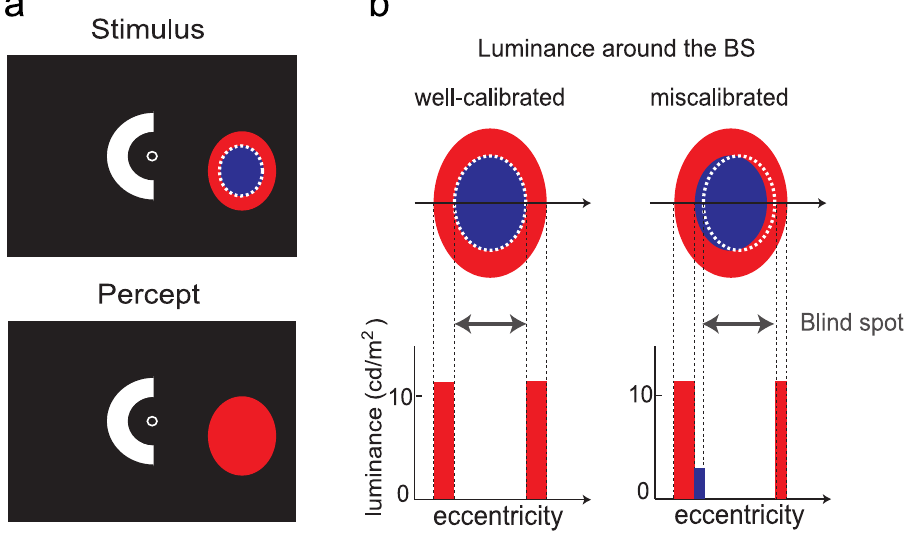
Figure 3. Stimuli used in Experiment 2 examining whether the darkening effect is due to light leakage outside the blind spot (BS). ( a ) Stimulus configuration. A red annulus surrounding the blue BS illumination was presented simultaneously with the test and reference arcs. ( b ) Schematic of the rationale for this control. If BS illumination was not properly confined within the BS, the total luminance available to the visual system would